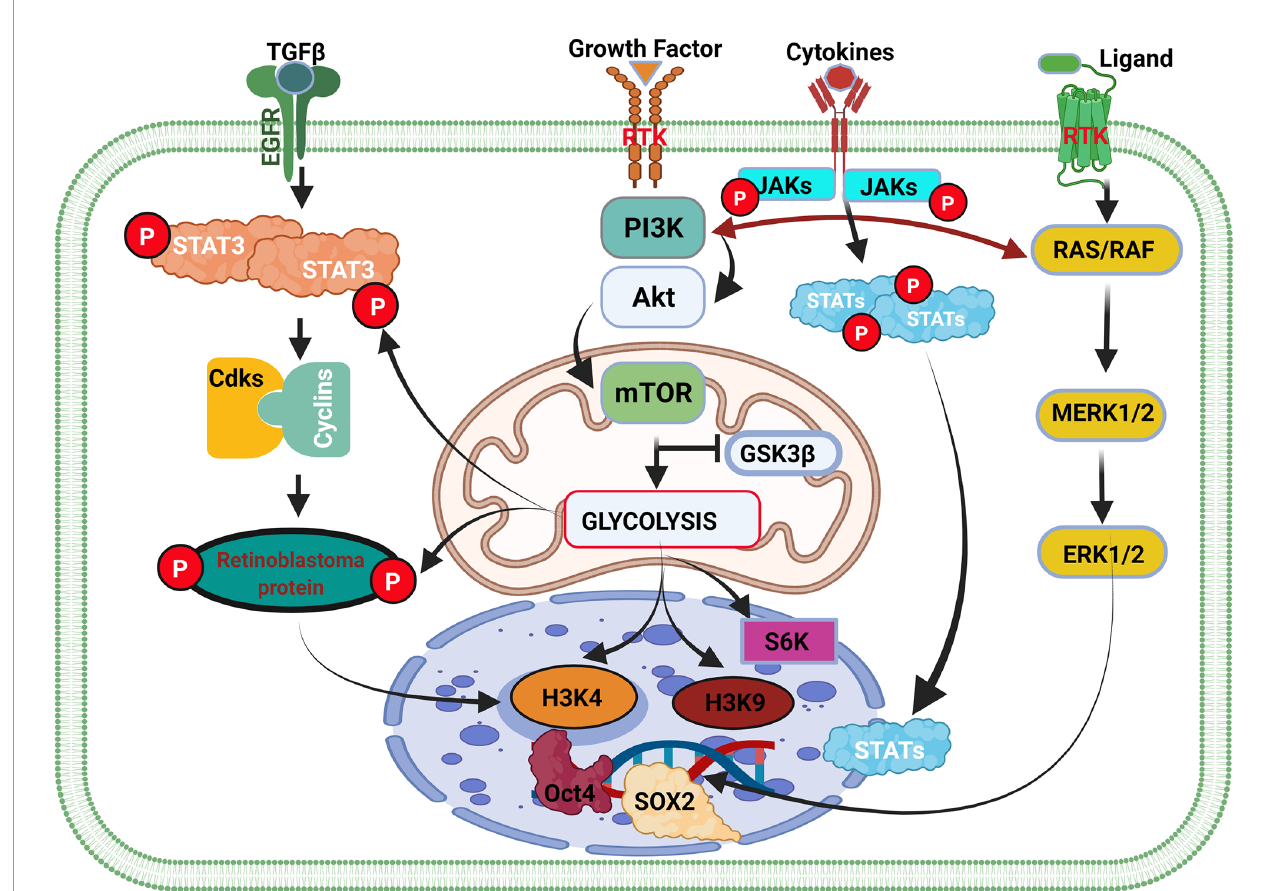
FIGURE 3 | Cell cycle genes and the weaknesses associated with the initiation of glioma. Cell type transition and cancer cell initiation are a succession of events within the cell-mediated by external and internal factors. The overexpression of GDNF in normal cells contributes to the activation of the STAT3 gene and cyclin- dependent kinase (Cdks) binding with cyclin and their respective phosphorylation. The binding of Cdks-cyclin promotes the activation and phosphorylation of retinoblastoma protein (Rb) that stimulates the initiation of the cell cycle and cell division via DNA transcription. In in fl ammation, the extracellular overexpression of growth factors activates the PI3K/AKT/mTOR pathway, which controls glycolysis by antagonizing GSK3 b activity. GSK3 b activation promotes glycogen synthesis to promote the accumulation of glycogen that can be used later to produce energy for cell survival and division. GSK3 b inhibition causes glycolysis to promote glioma initiation and epigenetic modi fi cation. In cancer, overexpression of GDNF or the activation of GDNF family ligands also promotes Ras/Raf signaling pathways leading to ERK1/2 activation and high expression. ERK1/2 translocate in the cell nucleus and regulate SOX1 family members ’ overexpression. Activation of the metabolism pathway (PI3K/AKT/mTOR) regulates oncogene expression via gene methylation and chromatin acetylation (H3K4 and